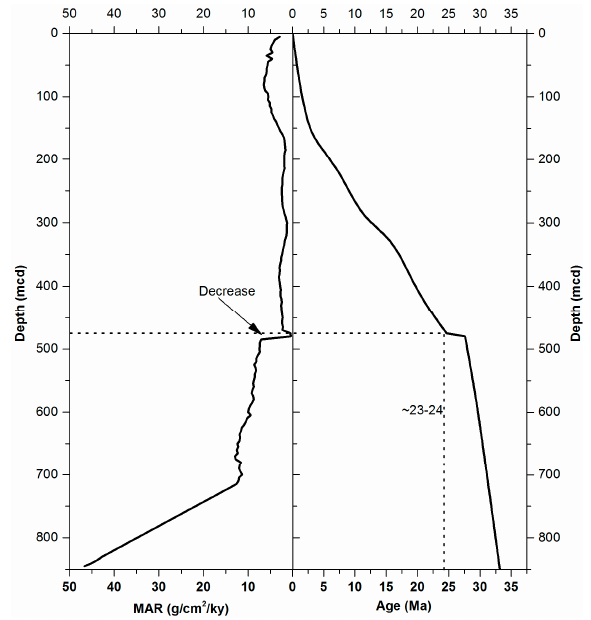
Figure 5. The mass accumulation rates (MAR) vs. depth and the age-depth model for ODP Site 1148. Data from Wang et al. (2000) [34].